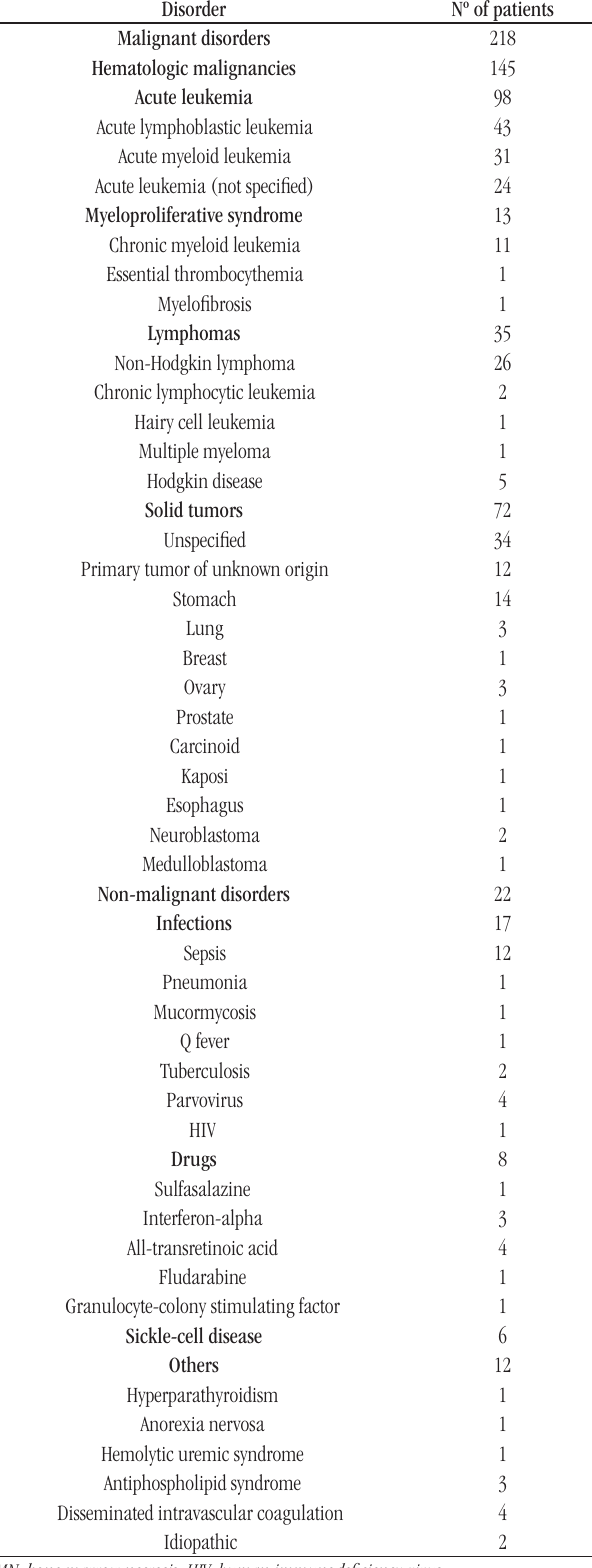
taBLE 2 − Disorders associated with BMN diagnosed in